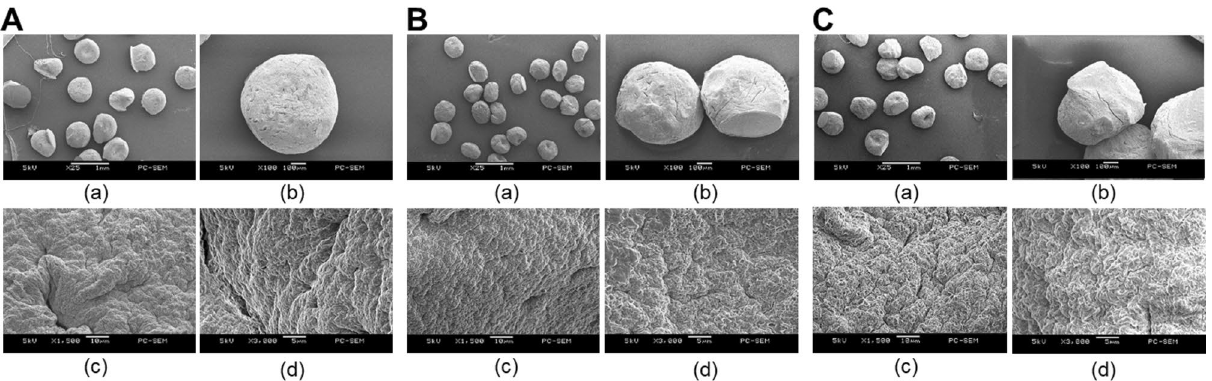
Figure 3. Scanning electron microscope (SEM) images of Dox-loaded calcium alginate microcarriers using parameter of (A) F1, (B) F2 and (C) F3, respectively, and F3 shows dense wrinkles thus increased surface area compared to F1 and